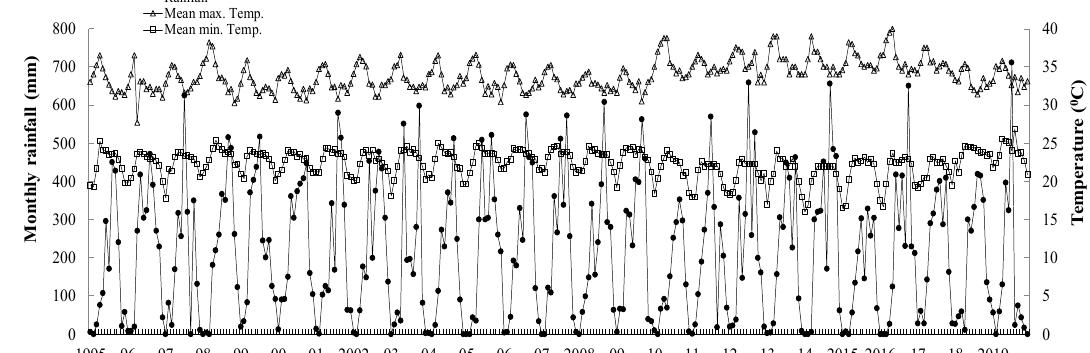
Figure 1. Mean monthly rainfall and temperatures (minimum and maximum) over the course of the four successive rotation cycles (1995–2019). Source: Dong Xoai Meteorological station located 20 km from the experimental site.